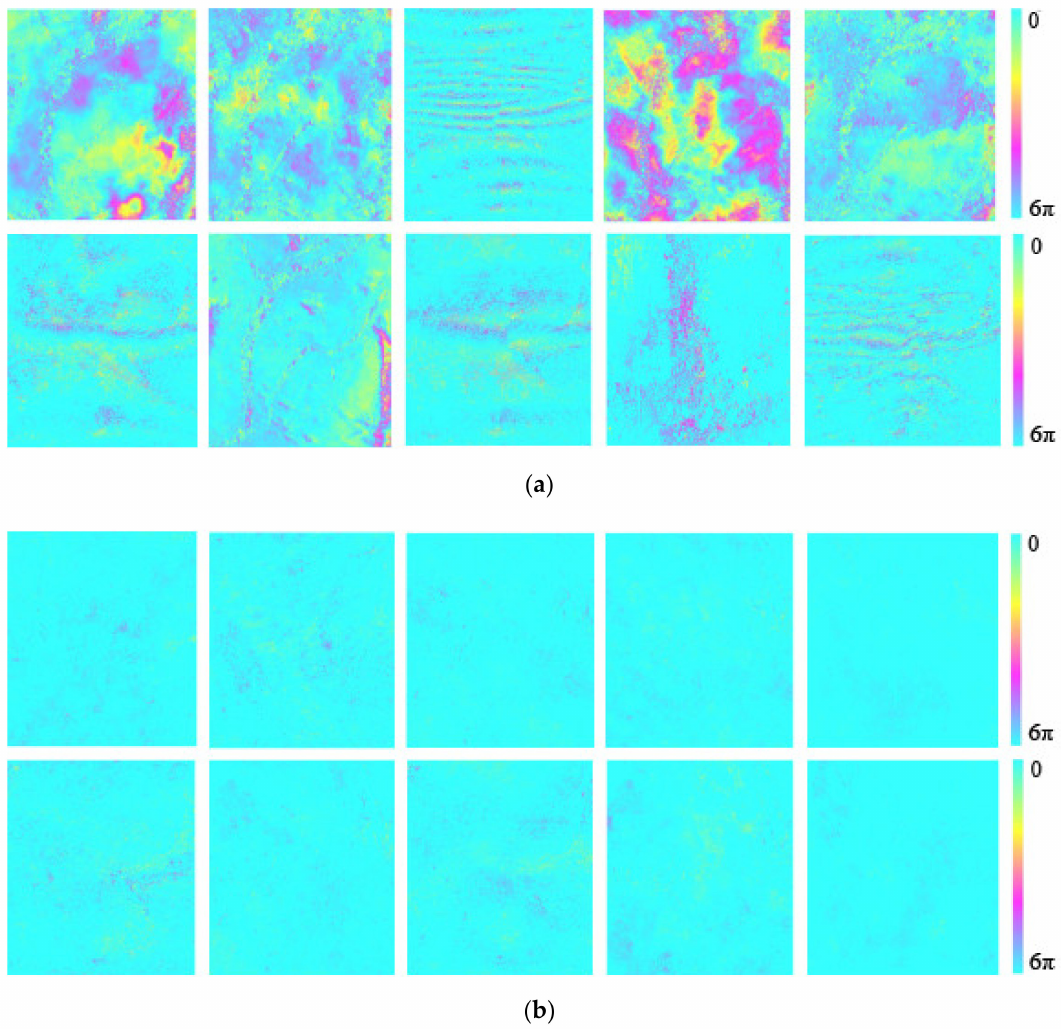
Figure 3. Training sets of unwrapped interferograms with ( a ) low quality and ( b ) high